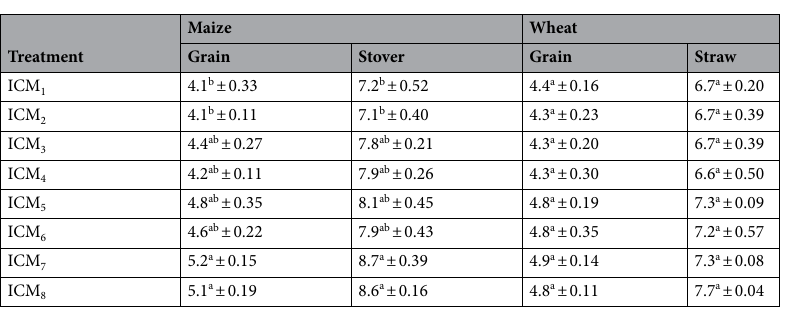
Table 1. Five years’ pooled grain and stover / straw (Mg ha −1 ) (± S.D.) yields of maize-wheat rotation under different ICM modules. Means followed by a similar lowercase letters within a column are not significantly different at p < 0.05 according to Tukey’s HSD test. # ICM 1&2 = conventional flatbed maize & wheat (CT FB ); ICM 3&4 = conventional raised bed maize & wheat (CT RB ); ICM 5&6 = zero-till (ZT) flatbed maize with wheat residue at ~ 3 Mg ha −1 (ZT M + W R ) & ZT wheat with maize residue at ~ 5 Mg ha −1 (ZT W + M R ), and ICM 7&8 = ZT raised bed maize with wheat residue (ZT RB + W R ) & ZT wheat with maize residue (ZT RB + M R ). # R DF = recommended fertilizers for maize / wheat 150:26.2:50 / 120:26:33 NPK kg ha fertilizer;